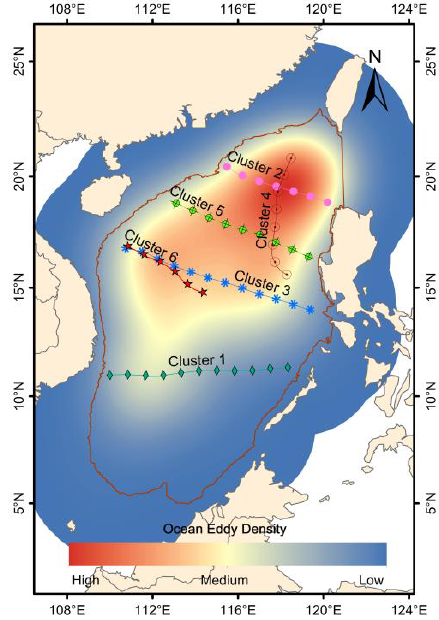
Figure 5. Clustering results after grouping the TC tracks into three, six, seven, and eight clusters. Table 2. The numbers and percentages of TCs that were grouped into the six different clusters by their tracks. The mean distances of all clusters are also provided.